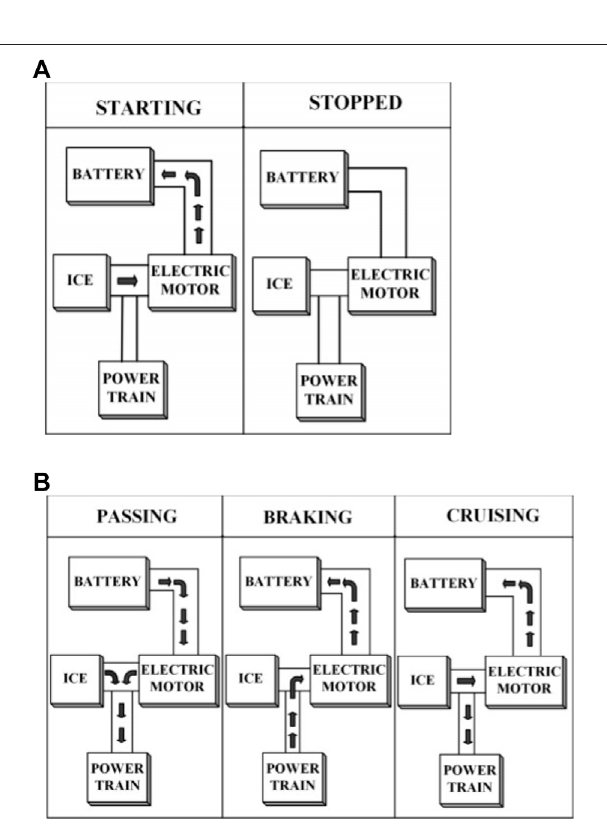
FIGURE 2 | (A) Direction of power fl ow during starting and stopped; (B) Direction of power fl ow during passing, braking, and cruising. Adapted from (Bayindir et al., 2015) for